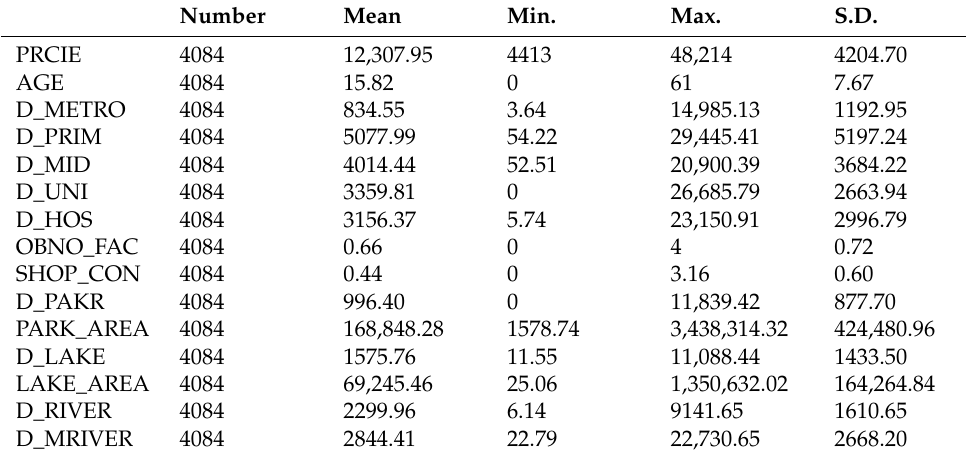
Table A8. Descriptive statistics of data in Chongqing.